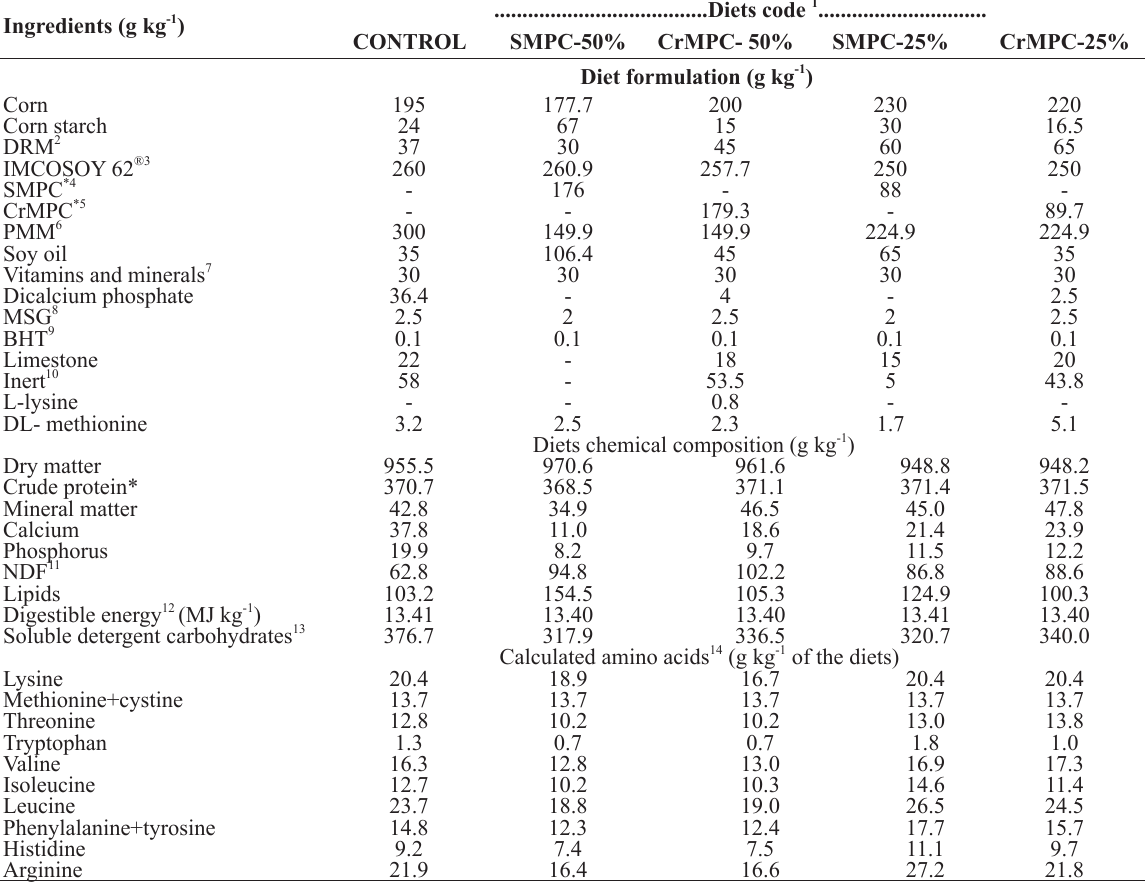
Formulation, chemical composition and calculated amino acids of the experimental diets containing protein concentrate of sunflower meal and crambe meal in different proportions in diet (g kg -1 ). Ingredients (g kg -1